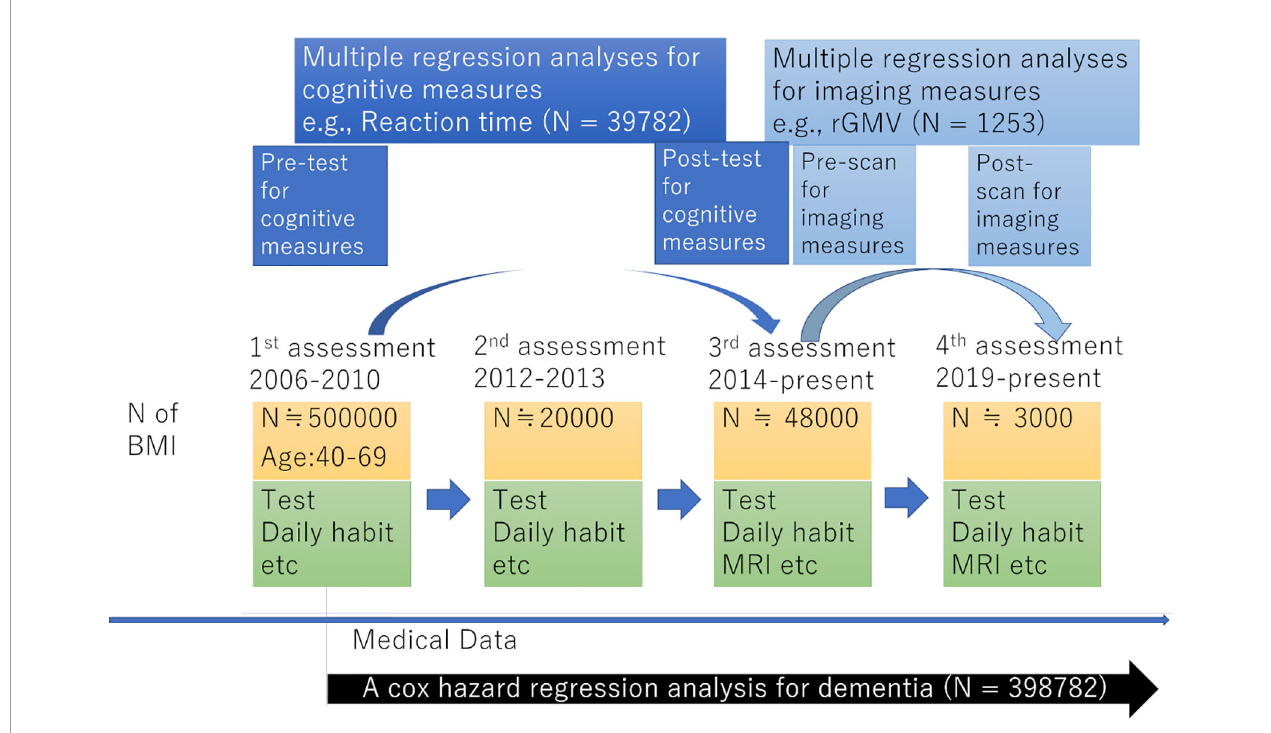
FIGURE 1 | A schema of the analyses of this study and its association with UK